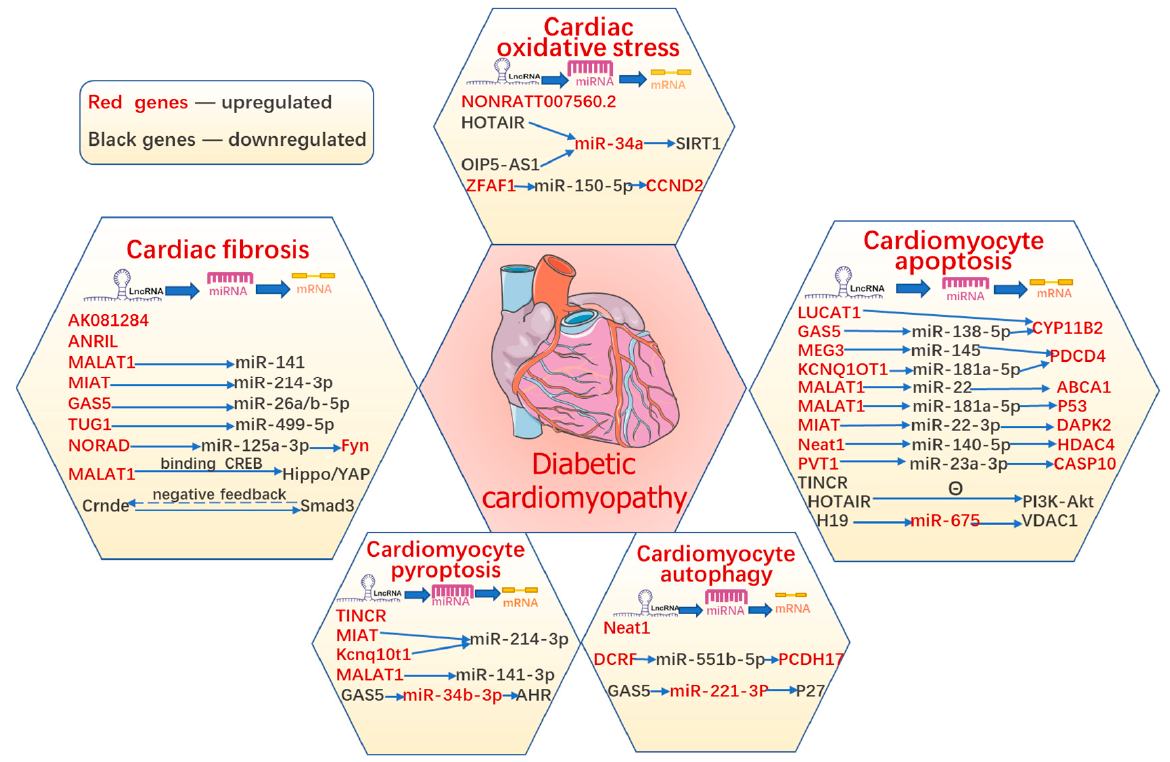
Figure 3. The role of lncRNAs in diabetic cardiomyopathy.